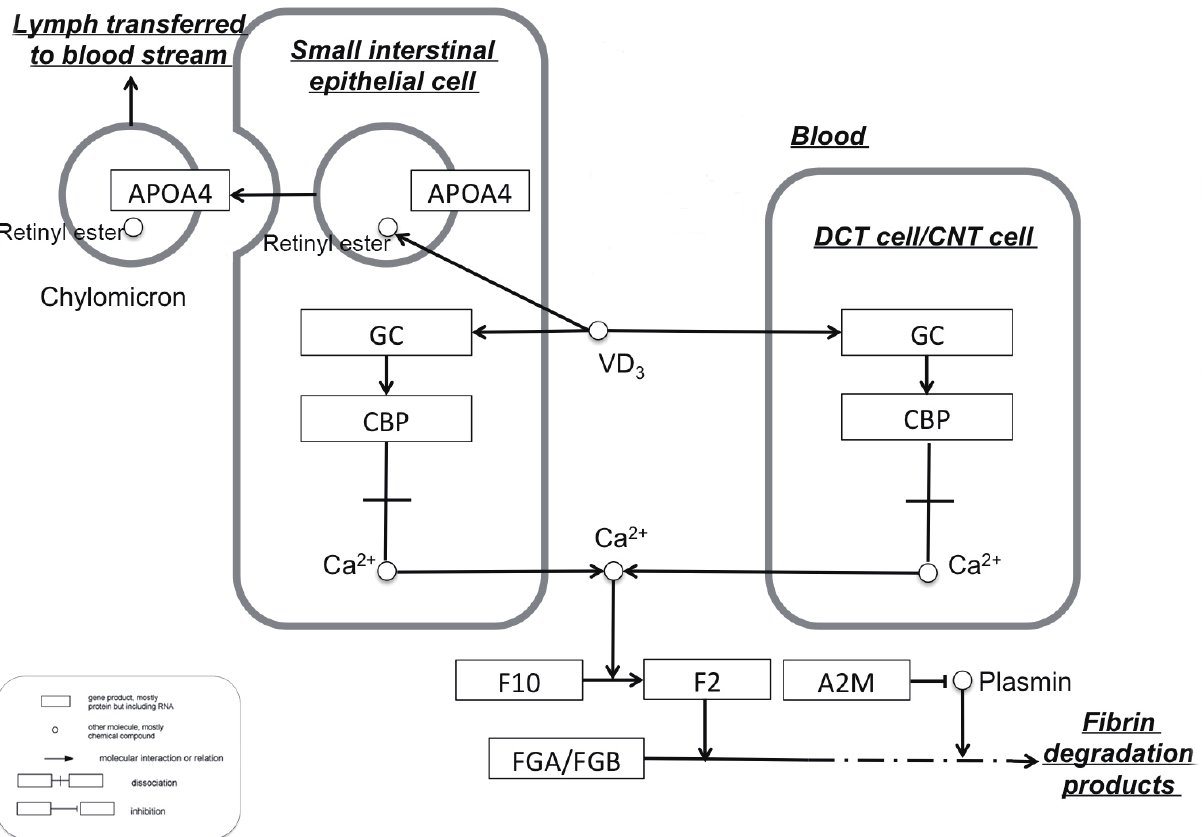
Figure 4. Pathway analysis. This is an integrated pathway to show the relationship between differentially expressed proteins and Ca regulation. The location and physiological process are indicated in italic and underlined font, respectively. APOA4, apolipoprotein A-IV; GC, vitamin D-binding protein; A2M, A2M protein; CBP, calcium binding protein; F2, blood coagulation factor 2; F10, blood coagulation factor 10; FGA, fibrinogen A chain; FGB, fibrinogen B chain. DCT cell, distal convoluted tubular cell; CNT cell, connecting tubular